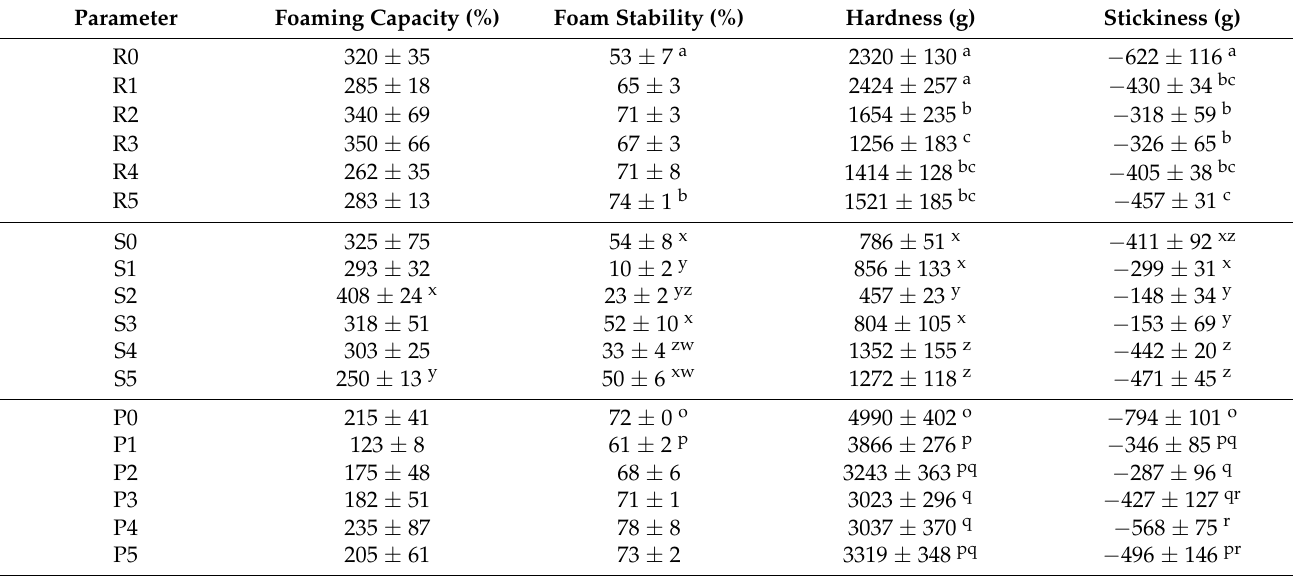
Different lowercase letters indicate statistically significant differences ( p < 0.05) between rows: (a, b, c, d, e, f) for rapeseed oil-made samples, (x, y, z, u, v, w) for sunflower oil-made samples and (o, p, q, r, s) for palm oil-made samples. The results are presented as the mean values ± standard deviation. Table 3. Results for foaming capacity, foam stability, hardness and stickiness for produced soap samples.